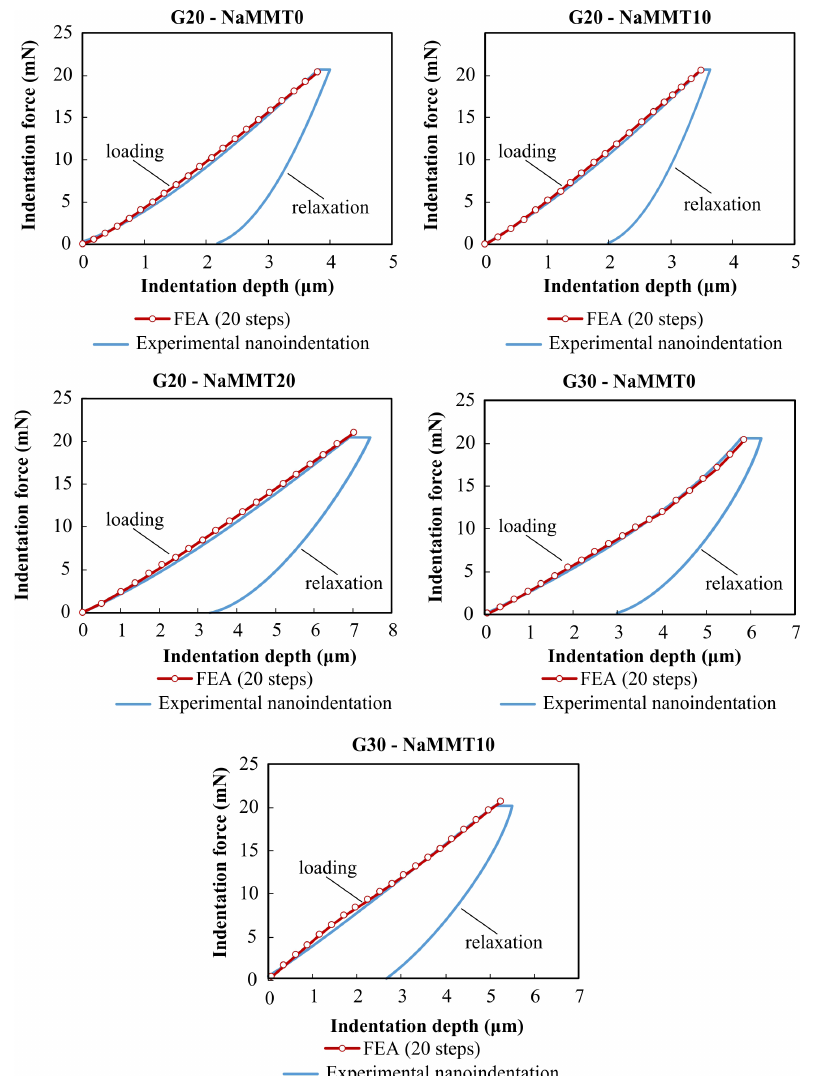
Figure 9. Comparison between FEA-determined and experimental nanoindentation tests.